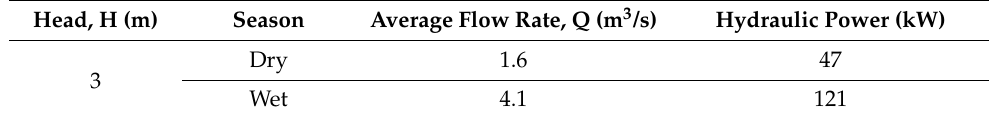
Table 3. Head, flow rate and hydraulic power for both seasons of the case study at the reference